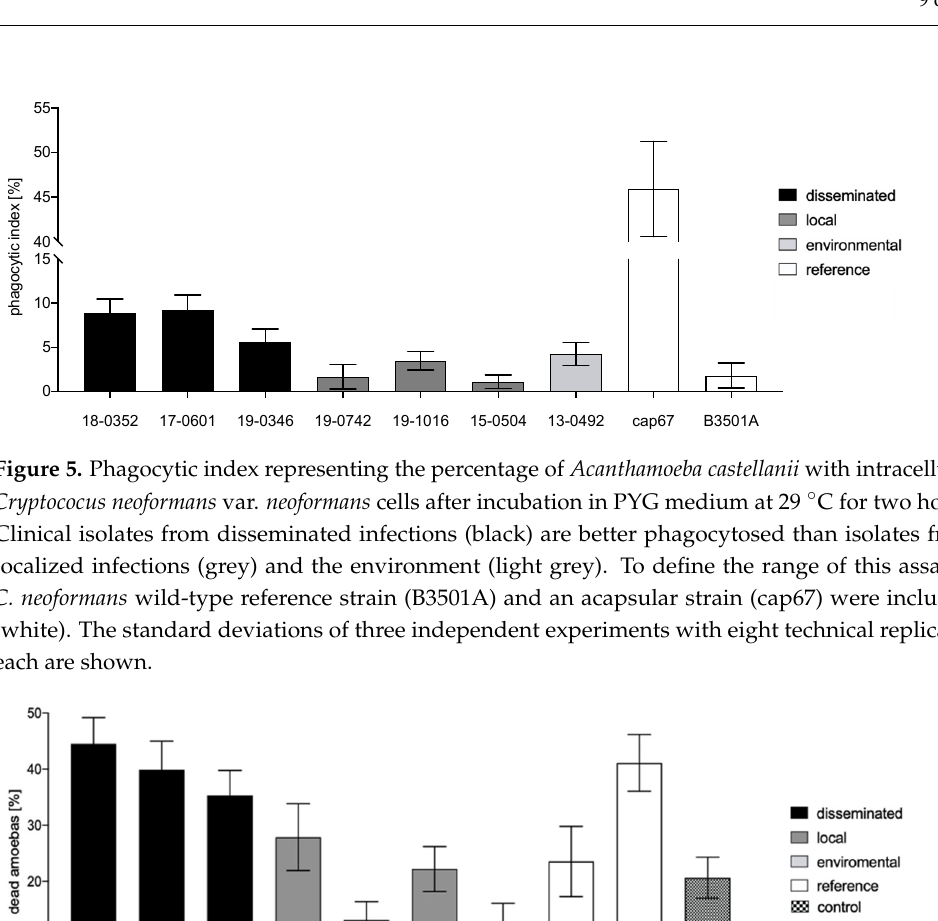
8 of 13 Figure 3. Urease activity of C. neoformans var. neoformans isolates from disseminated infections (black), localized soft tissue infections (grey), and the environment (light grey). A total of 5 µL containing 10 6 cells were spotted on Christensen’s urea agar and incubated at 30 °C for 48 h. Halos surrounding colonies were measured digitally. Black lines show means with standard deviation of three biological replicates with two measurements each. Figure 4. Phospholipase activity of C. neoformans var. neoformans isolates from disseminated infections (black), localized soft tissue infections (grey), and the environment (light grey). A total of 5 µL containing 10 6 cells were spotted on egg yolk agar and incubated at 30 °C for five days. Halos surrounding colonies were measured digitally. Black lines show means with standard deviation of three biological replicates with two measurements each. Dots show individual data points. 3.3. Isolates from Disseminated Infections Demonstrate Higher Uptake and Cytotoxicity for Acanthamoeba Coincubation of C. neoformans var. neoformans with A. castellanii resulted in significantly different phagocytosis indices with C. neoformans var. neoformans reference strain B3501A and acapsular mutant strain cap67 defining the detectable range of the method performed ( p < 0.0001; Figure 5). While almost all C. neoformans var. neoformans isolates resulted in a higher phagocytic index than B3501A (1.8%), they all demonstrate